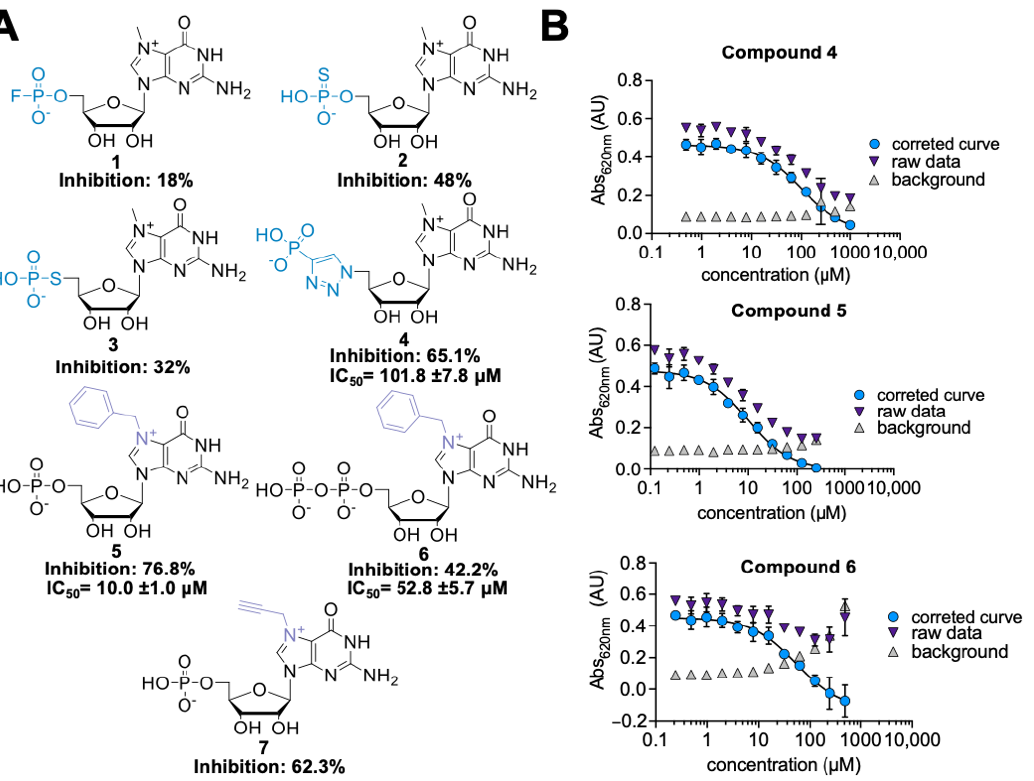
Figure 2. ( A ) Structures of the most potent hits identified in the first library of cN ‐ IIIB inhibitors. ( B ) IC 50 curves for compounds 4, 5 , and 6 . The IC 50 values were determined using MGP assay. The data present mean values ± SD from triple independent experiments. To determine the IC 50 values, a standard dose ‐ response equation was fitted to the data corrected for the background absorbance of the inhibitor alone.